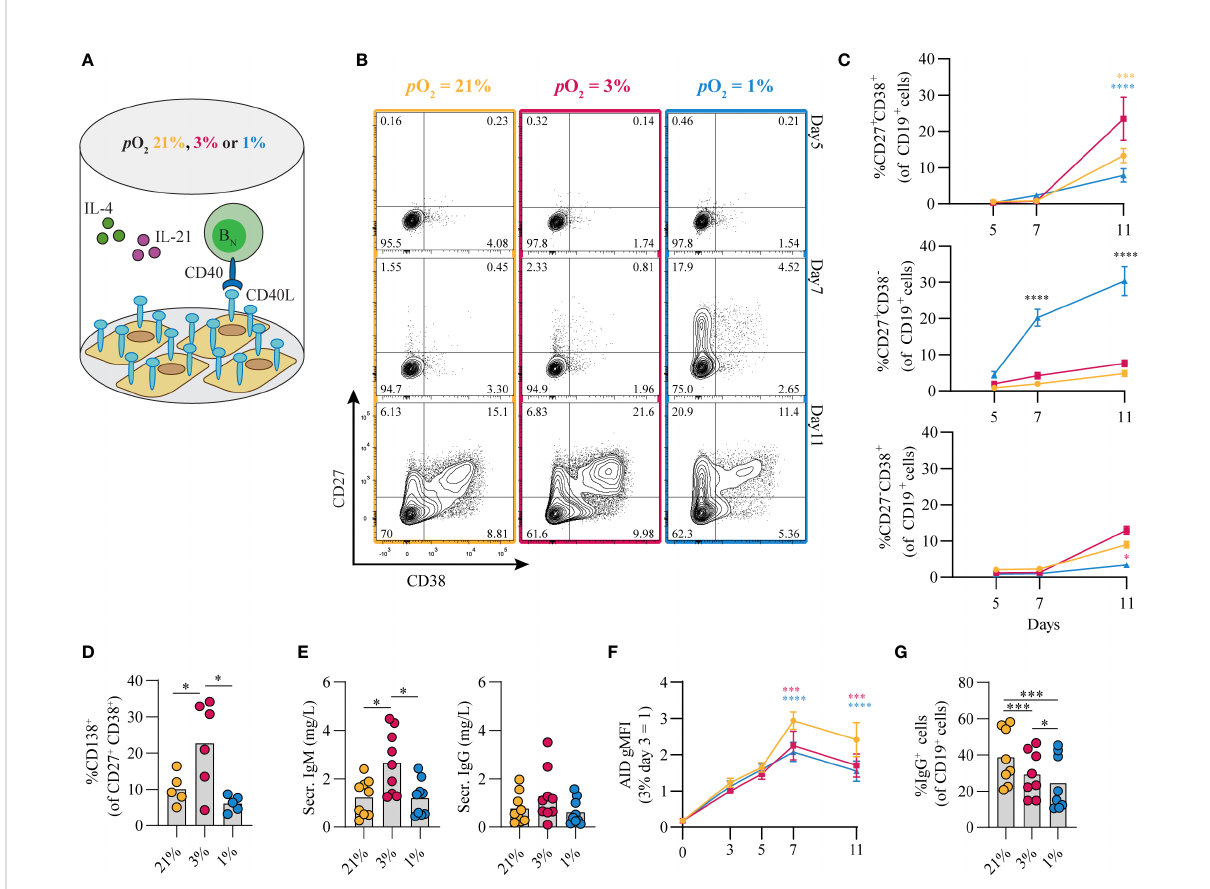
FIGURE 1 Differential p O 2 controls human B cell differentiation into CD27 + and antibody secreting cell compartments. (A) Schematic overview of B cell in vitro culture system. 250 resting human naive B cells (CD19 + CD27 - IgD + ) were stimulated using a human CD40L-expressing feeder cell layer (subtype p O ‘ High ’ (12),); recombinant human IL-4 (25ng/ml) and IL-21 (50ng/ml); and cultured at 5% p CO 2 and 21, 3, or 1% 2 for a maximum of 11 days. (B) Representative biaxial CD27/CD38 FACS plots after 5, 7, and 11 days of culture at 21, 3, or 1% p O 2 . (C) Quanti fi cation of the percentages of CD27 and CD38 subpopulations within total CD19 + B cells over time ( n = 9). (D) CD138 expression within the CD27 + CD38 + antibody secreting cell population ( n = 6). (E) Cumulative secretion of IgM and IgG measured in culture supernatants after 11 days ( n = 9). (F) gMFI of AID expression over time ( n = 3). (G) Percentage of IgG + cells within CD19 + B cells, combined surface and intracellular staining ( n = 8). Bars represent means of biological replicates each composed of 2 technical replicates in (D, F) 2, (E, G) 3 or (C) 4 independent experiments. Statistical differences